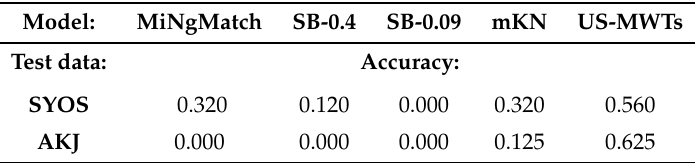
Table 11. Word-level Accuracy for OoV words (best models